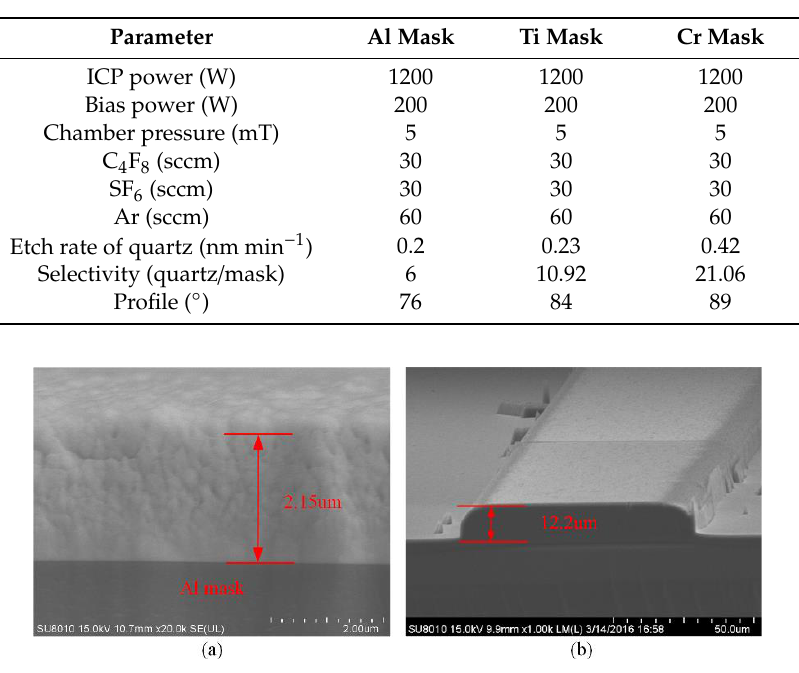
Figure 7. The relationship between the chamber pressure and etch rate.